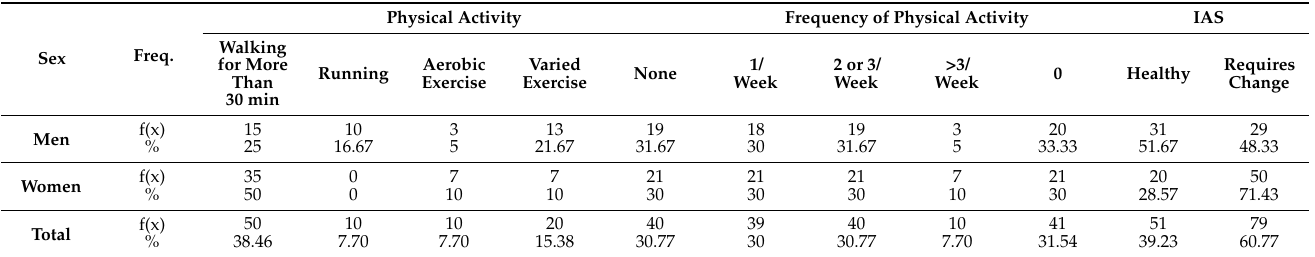
Table 7. Physical activities engaged in for recreation of health, frequency of engagement, and healthy eating